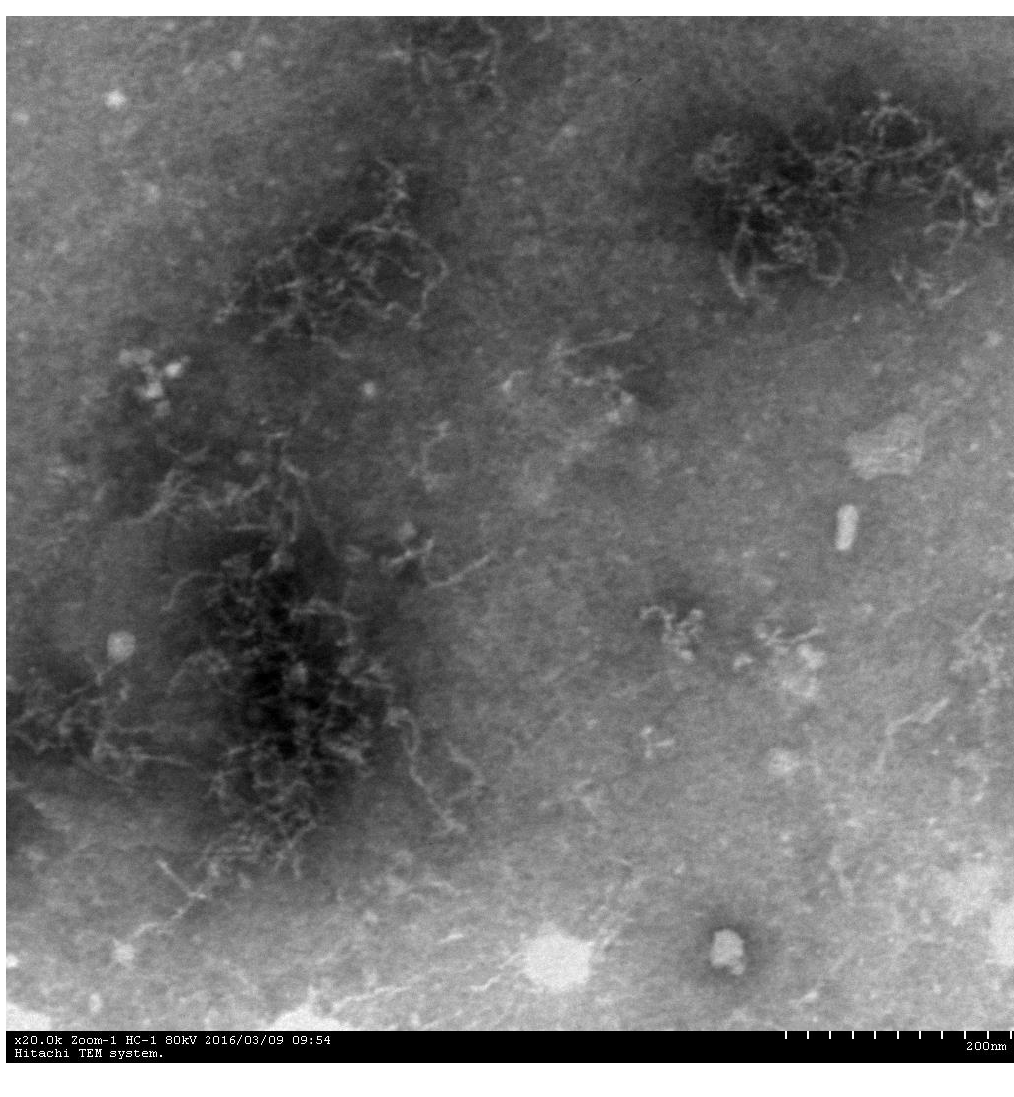
Figure 1. TEM image analysis of Aβ (1 -42) aggregation. ( a ) Aβ (1 -42) alone (20 µM) was incubated at 37 °C for 0 h; ( b ) Aβ (1 -42) alone (20 µM) was incubated at 37 °C for 24 h; ( c )Aβ (1 -42) (20 µM) and tacrine (50 µM) were incubated at 37 °C for 24 h; ( d ) Aβ (1 -42) (20 µM) and 8q (50 µM) were incubated at 37 °C for 24 h.